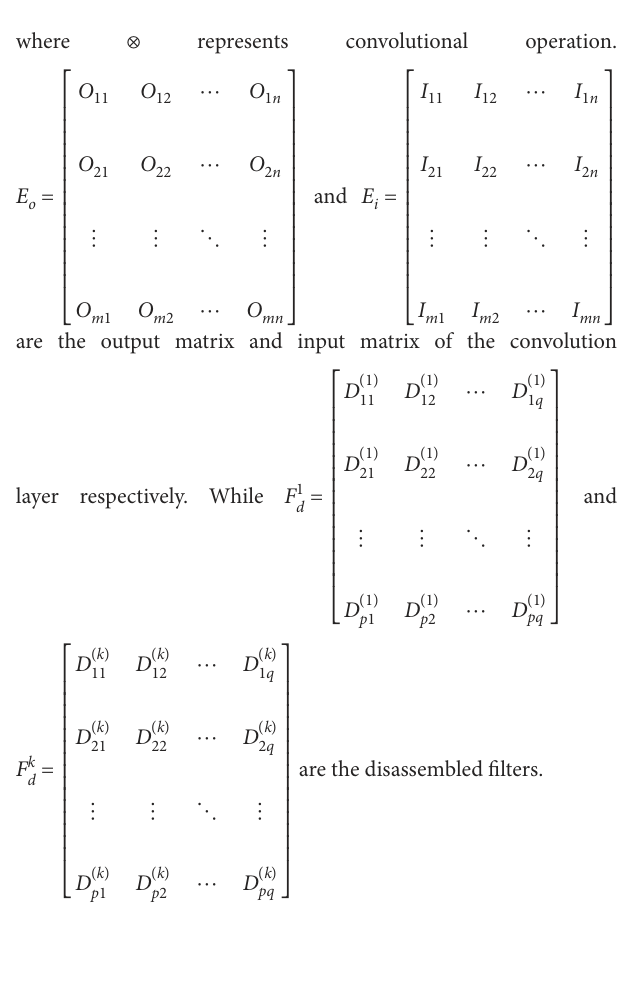
where ⊗ represents convolutional operation. = 0 . 5 η ( T − 1 ) . If validation j j E o